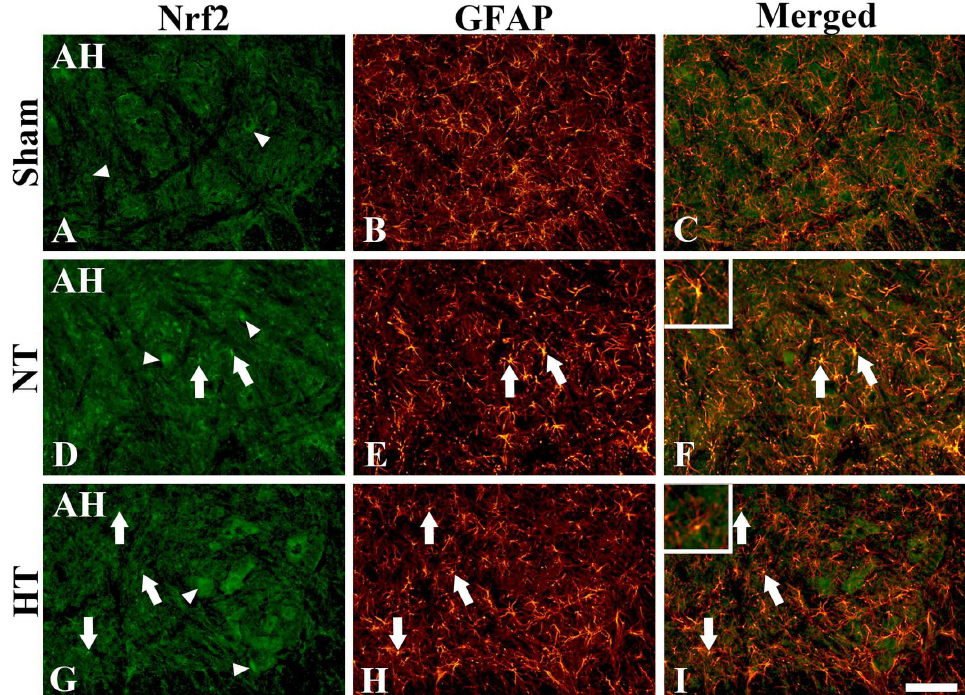
Figure 6. Double immunofluorescence for Nrf2 (green; A , D , G ), GFAP (red; B , E , H ), and merged ( G , F , I ) images in the anterior horn of the sham-NT or HT ( A – C ), CA-NT ( D – F ), and CA-HT ( G – I ) groups at 24 h after CA/ROSC. Nrf2 immunoreactivity is mainly found in the cytoplasm of motor neurons (arrowheads) and astrocytes in all groups, showing that, in the CA-NT and CA-HT groups, Nrf2 immunoreactivity is found in both the cytoplasm and nucleus of some motor neurons. Note that arrows indicate Nrf2 + astrocytes, which show the nuclear pattern of Nrf2 immunoreactivity in the CA-NT and CA-HT groups. Upper left boxes show the enlargement of an astrocyte with nuclear Nrf2 immunoreactivity. AH, anterior horn. Scale bar = 50 µm.